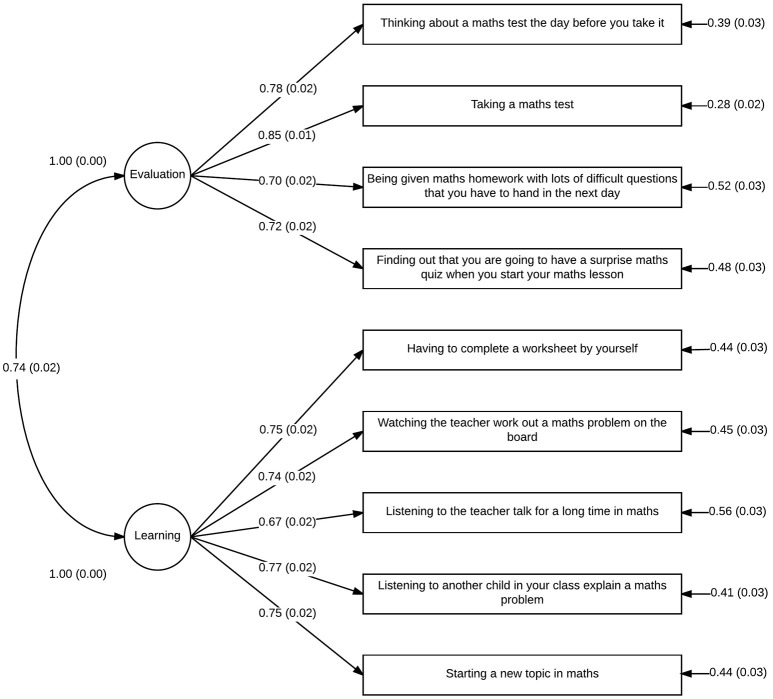
Confirmatory factor analysis of mAMAS: path diagram for year 7/8 students.